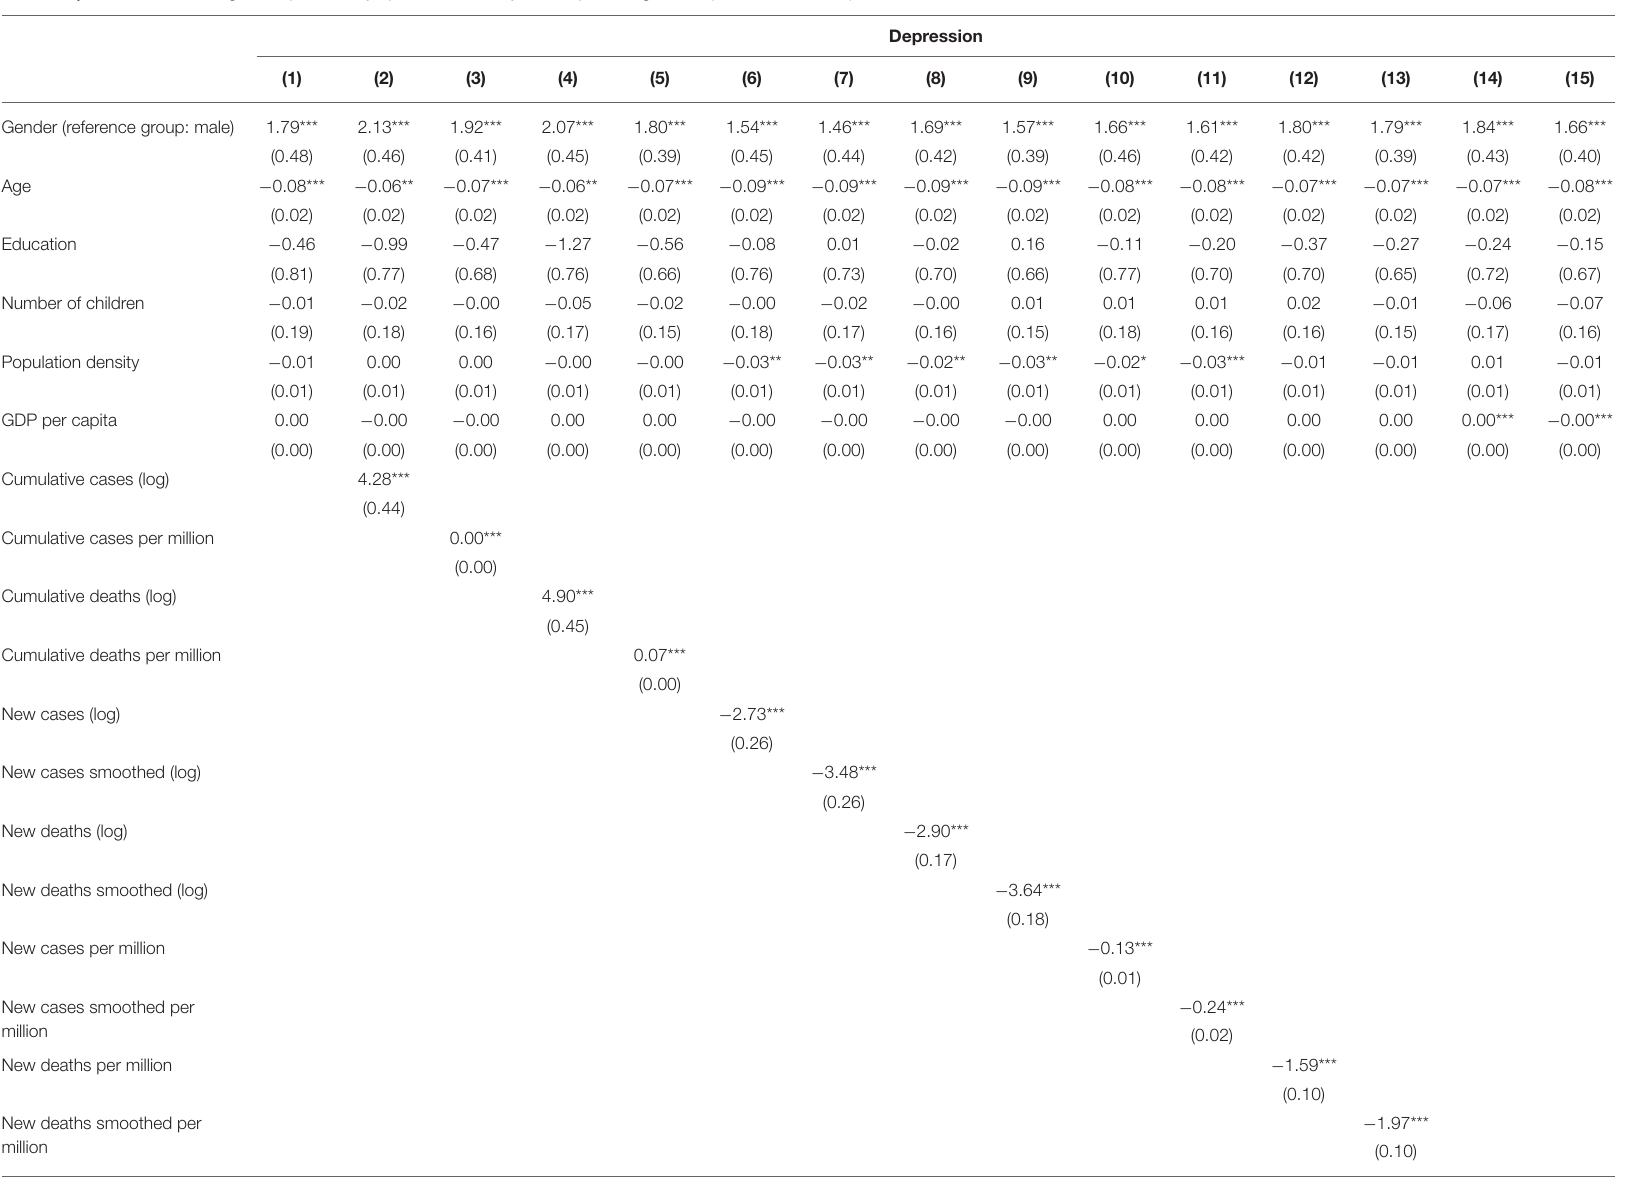
TABLE 6 | Predictors of managers’ depression symptoms in ordinary least squares regression ( n = 812, N =